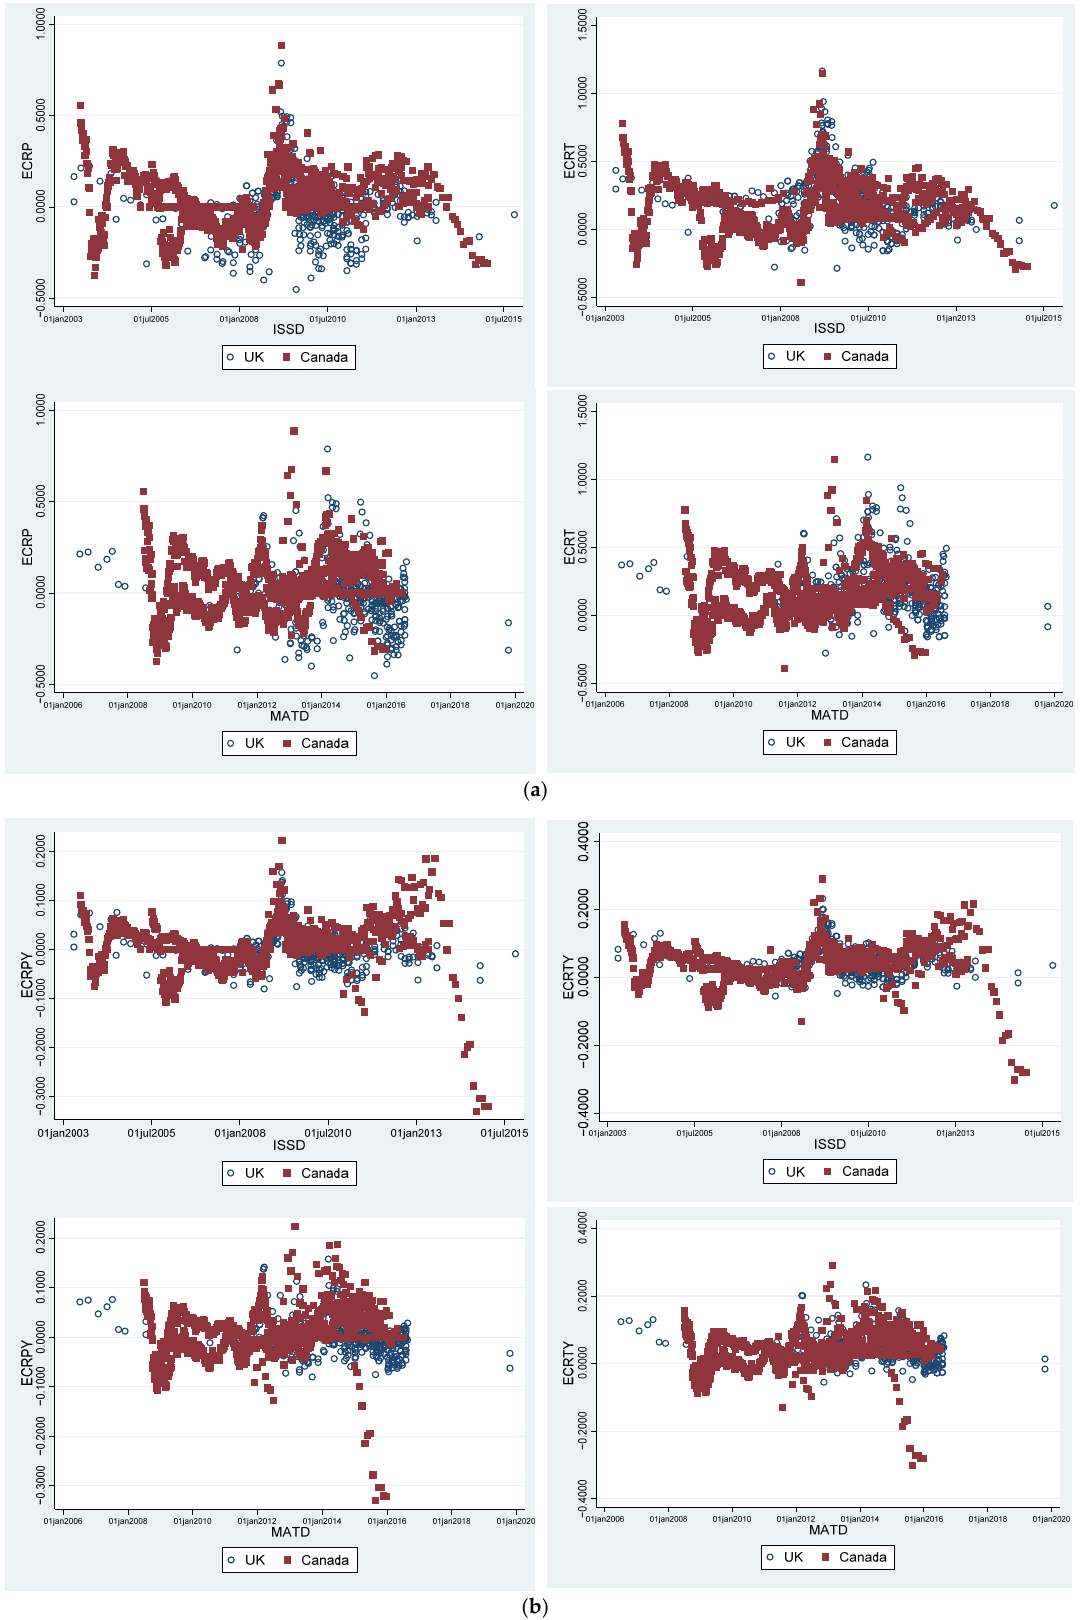
Figure 3. ( a ) The excess return ECRP , ECRT by ISSD and MATD ; ( b ) The annualized excess return ECRPY , ECRTY by ISSD and MATD .